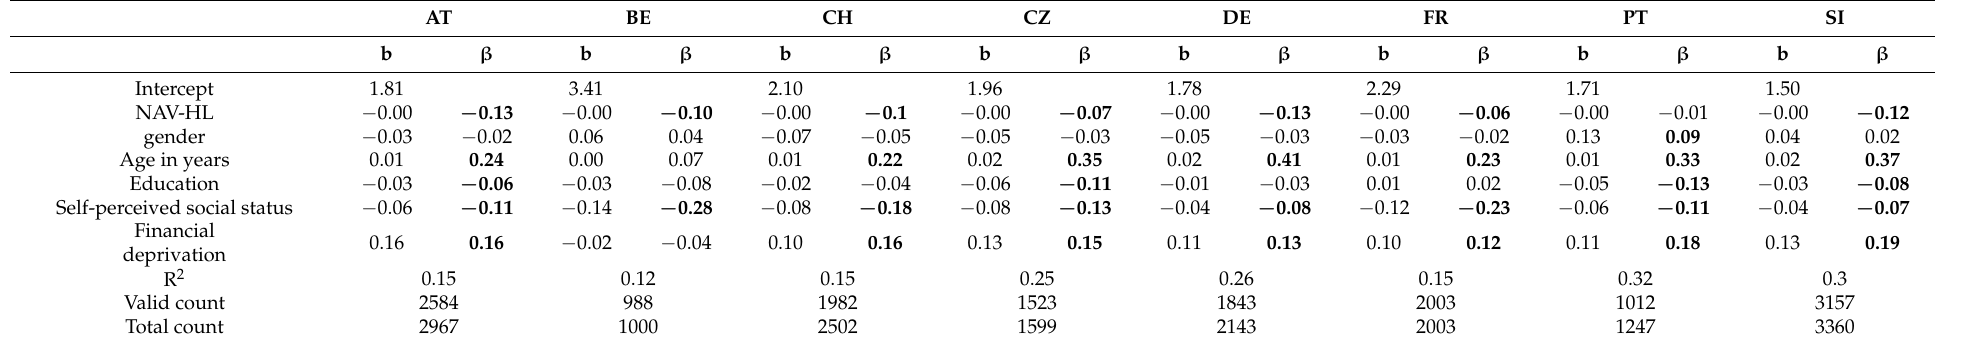
Table 10. Multivariable linear regression models of self-reported general health status (dependent variable) by NAV-HL score and other social variables